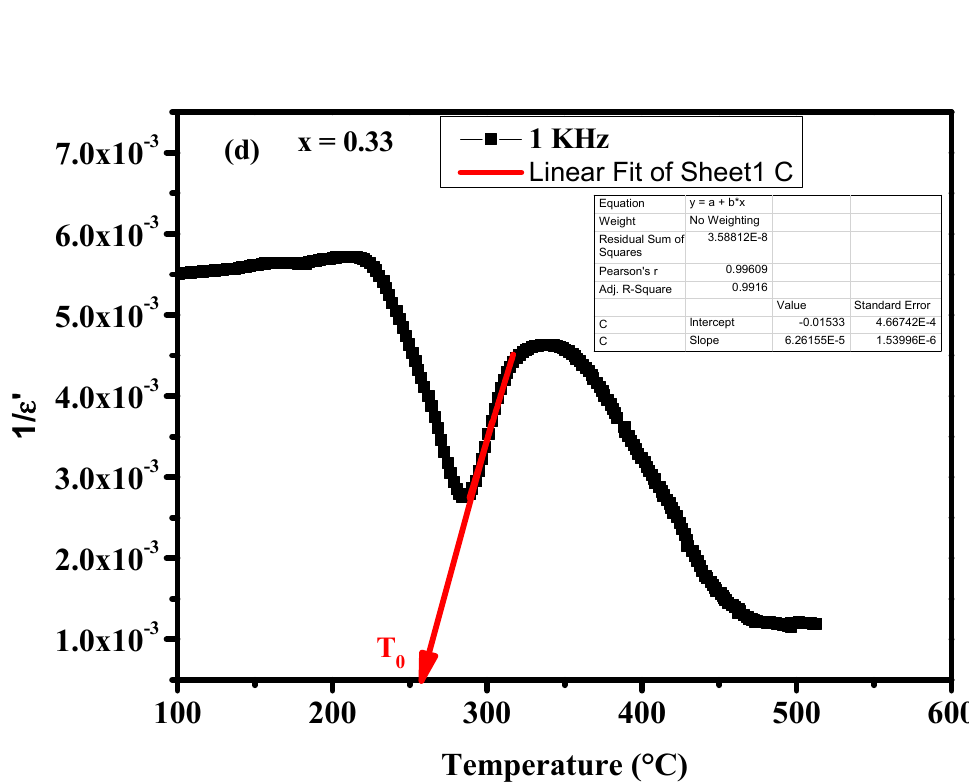
Figure 6. ( a − d ) Thermal evolution of 1